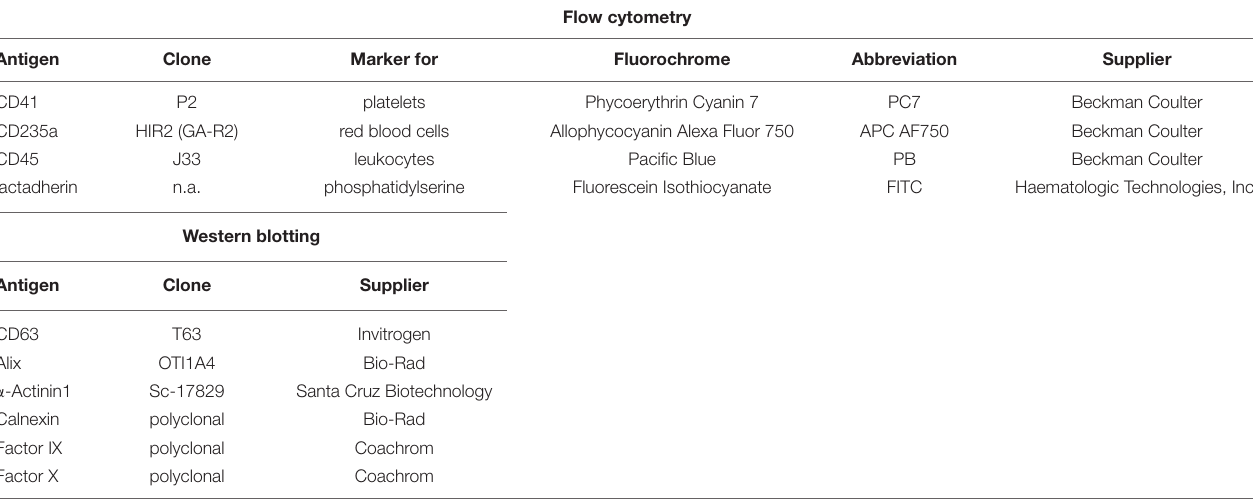
TABLE 1 | Antibodies and fluorochrome conjugates used for flow cytometry and Western